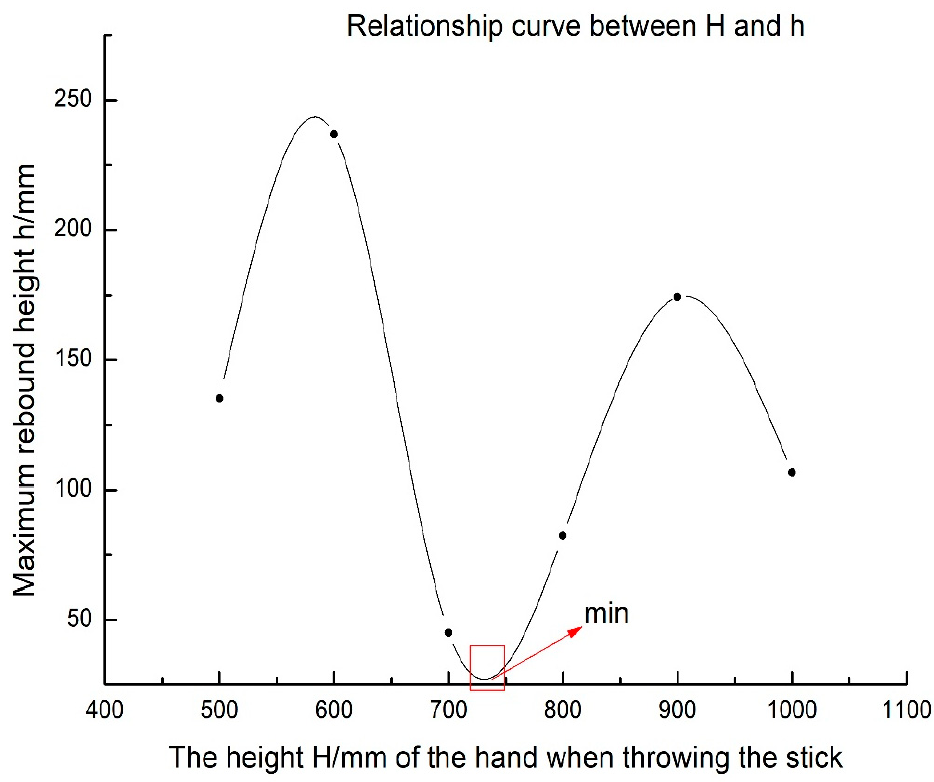
Figure 8. The relation graph between the height H of the hand and the height h of the maximum rebound of the cudgel tip.